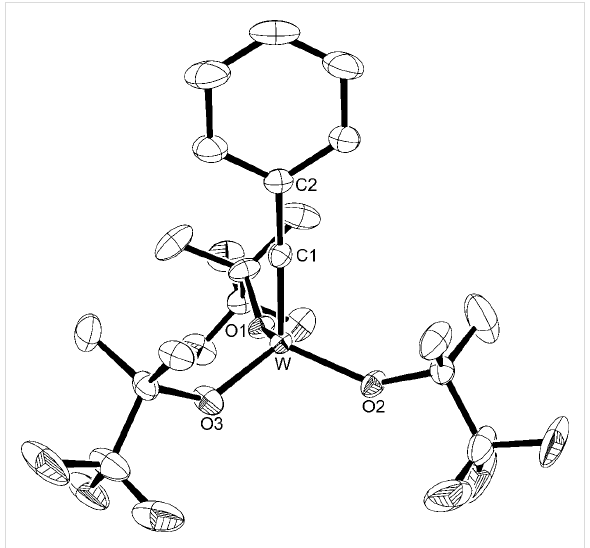
Figure 3: Molecular structure of W Ph F3 with thermal displacement pa- rameters drawn at 50% probability. Hydrogen atoms and minor compo- nents of the disordered OC(CF 3 )Me 2 groups are omitted for